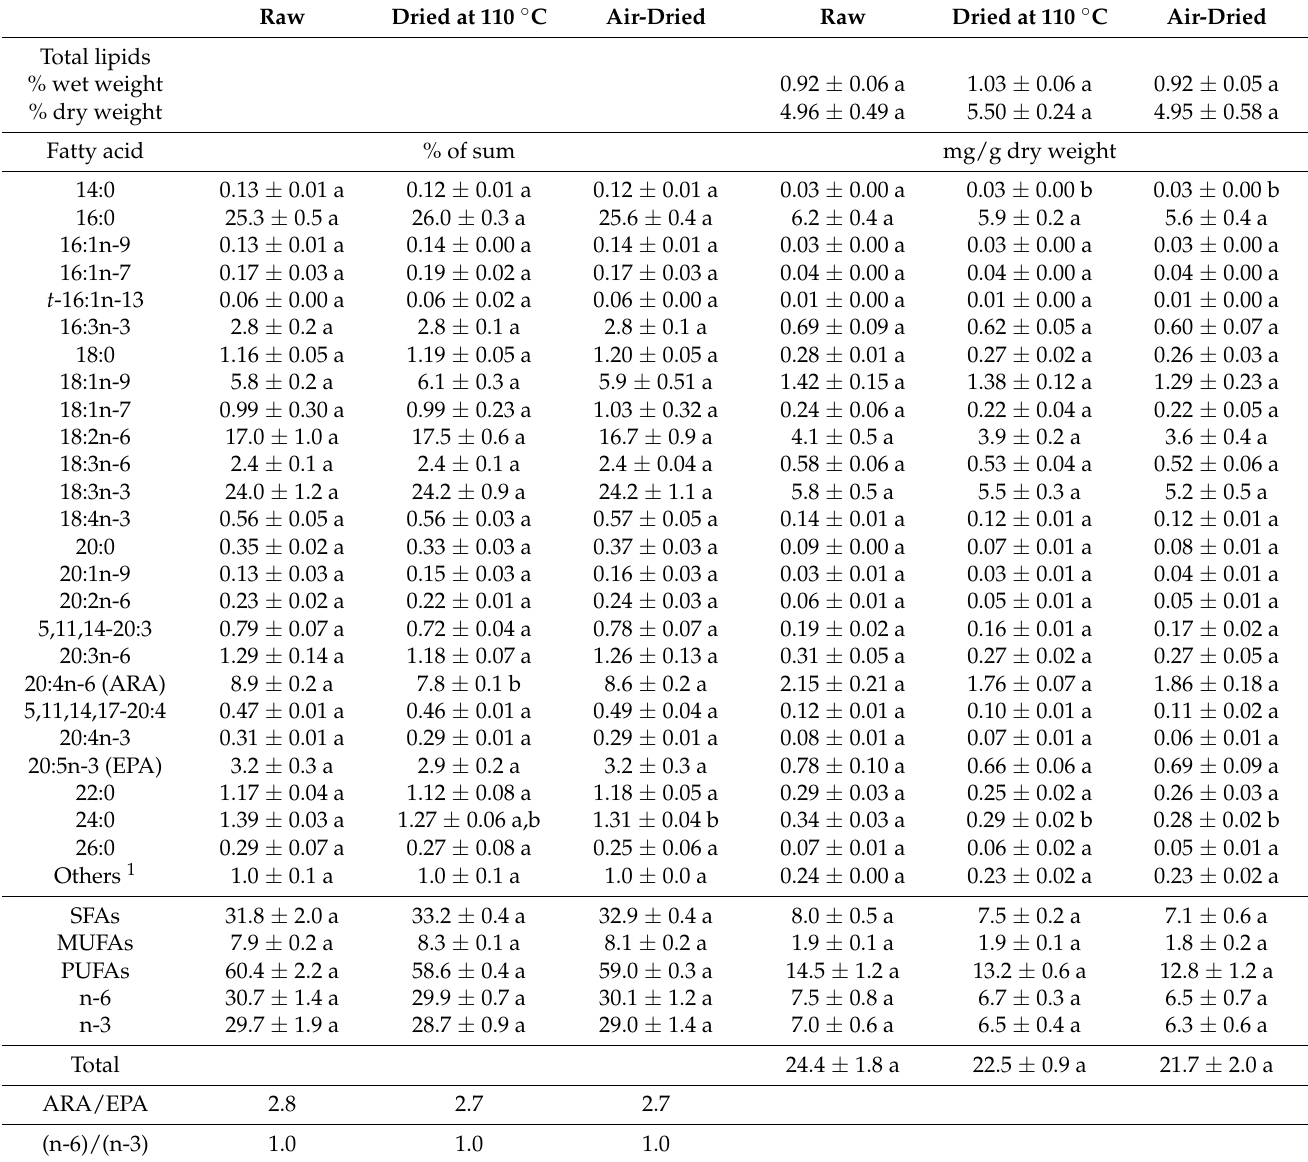
Table 4. Lipid and fatty acid content of raw and processed fiddleheads of Osmundastrum asiaticum . Raw Dried at 110 ◦ C Air-Dried Raw Dried at 110 ◦ C